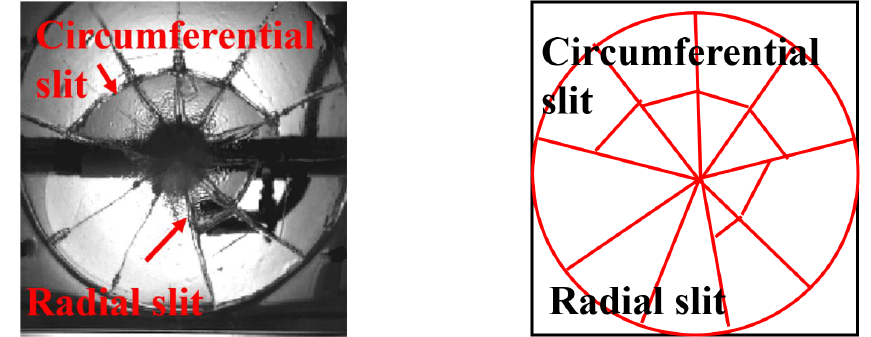
Figure 10. Radial and circumferential slits pattern when H = 0.59, T = 0.17.